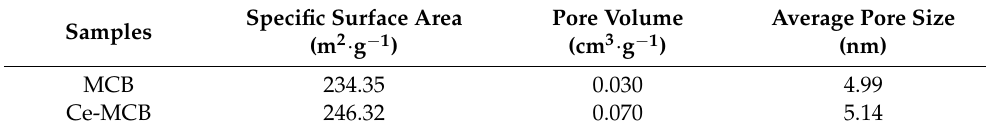
Table 1. Pore structural parameters of